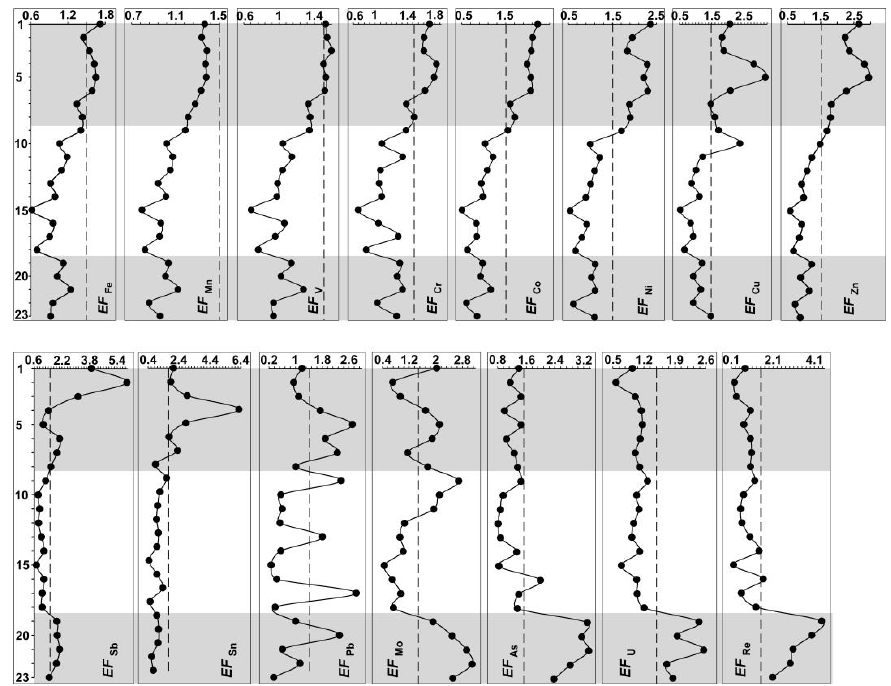
Figure 6. The vertical profile of EF values of environmentally significant major (Fe), minor (Mn), and trace elements. The EF values for Cr, Co, Ni, Cu, and Zn are slightly enriched in the upper unit, whereas the lower unit shows higher EF values for Mo, As, U, and Re than the other two units